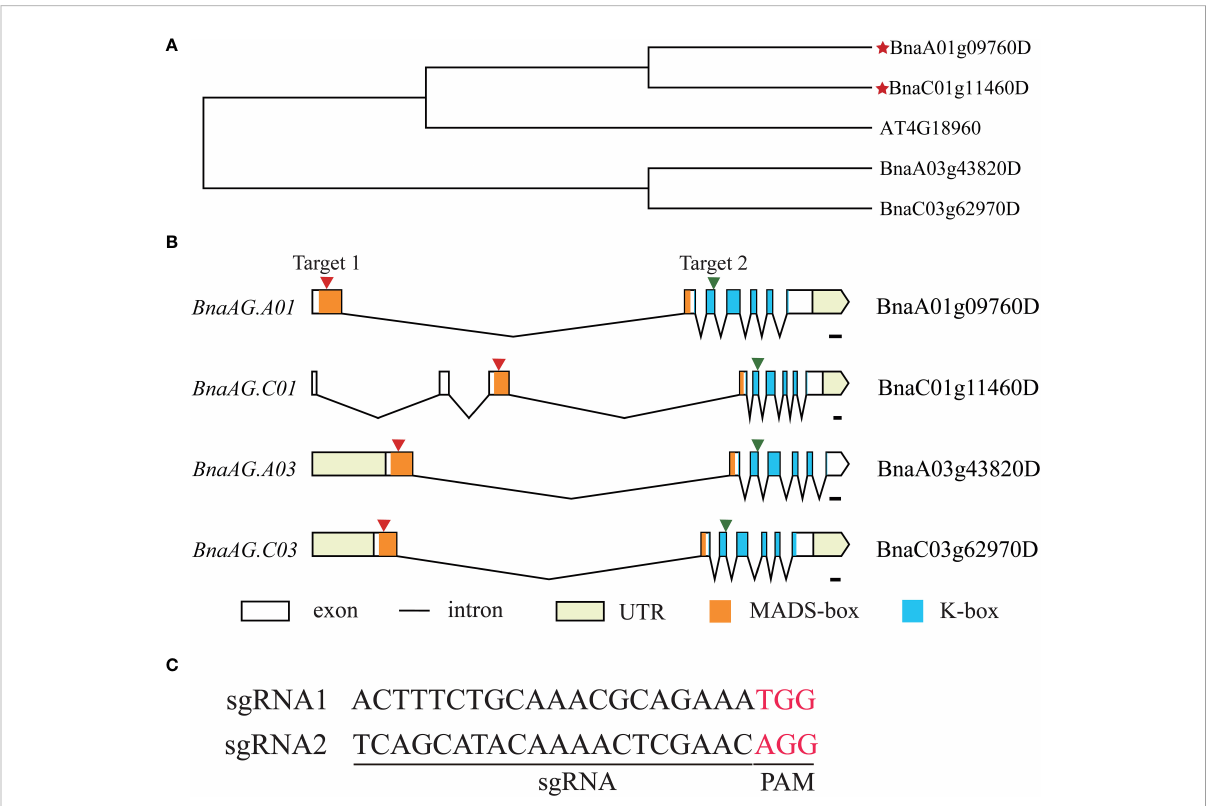
FIGURE 7 Construction of vectors for targeting BnaAG homologous genes. (A) NJ tree of BnaAG homologous genes in B napus and A thaliana . The red stars represent the BnaAG homologs of B napus closely related to the AG gene in A thaliana . (B) Gene structure, conserved domain, and distribution of sgRNA1 and sgRNA2 targeting four homologous genes of BnaAG . The black line represents introns, and the black boxes represent the exon. The red arrows indicate the location of sgRNA targets on the exon, and the orange and blue boxes represent MADS-box and K-box domains, respectively. (C) Sequence information of two sgRNA, PAM is indicated in